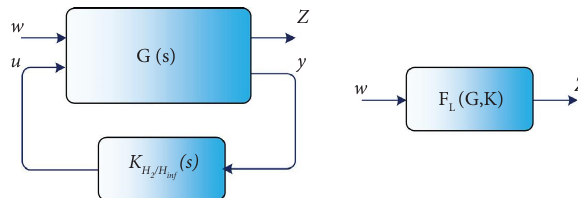
Figure 7: Te standard LFT confguration for H